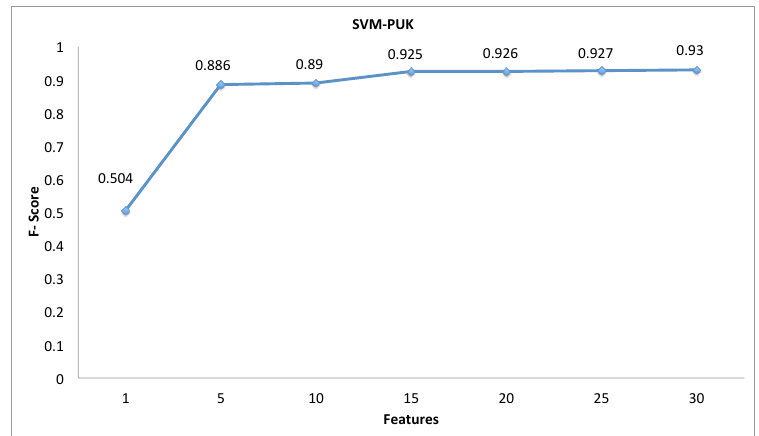
Figure 5. F-score per features used for the smartwatch at 10 Hz with a Support Vector Machine (SVM) using a Pearson Universal Kernel (PUK).